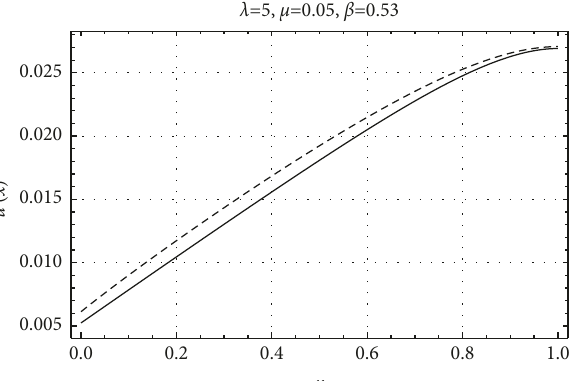
Figure 2: GDTM solution: q � 1 . 9 and c � 1 (line); q � 1 . 9 and c � 0 . 9 (dashed).